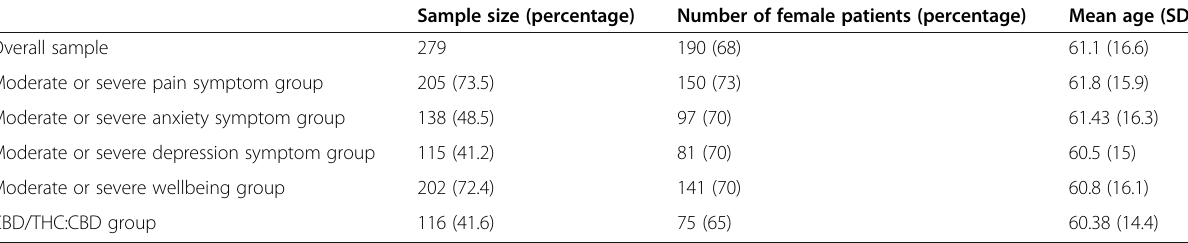
Table 2 Demographic characteristics of 279 medical cannabis patients, by symptom group Sample size